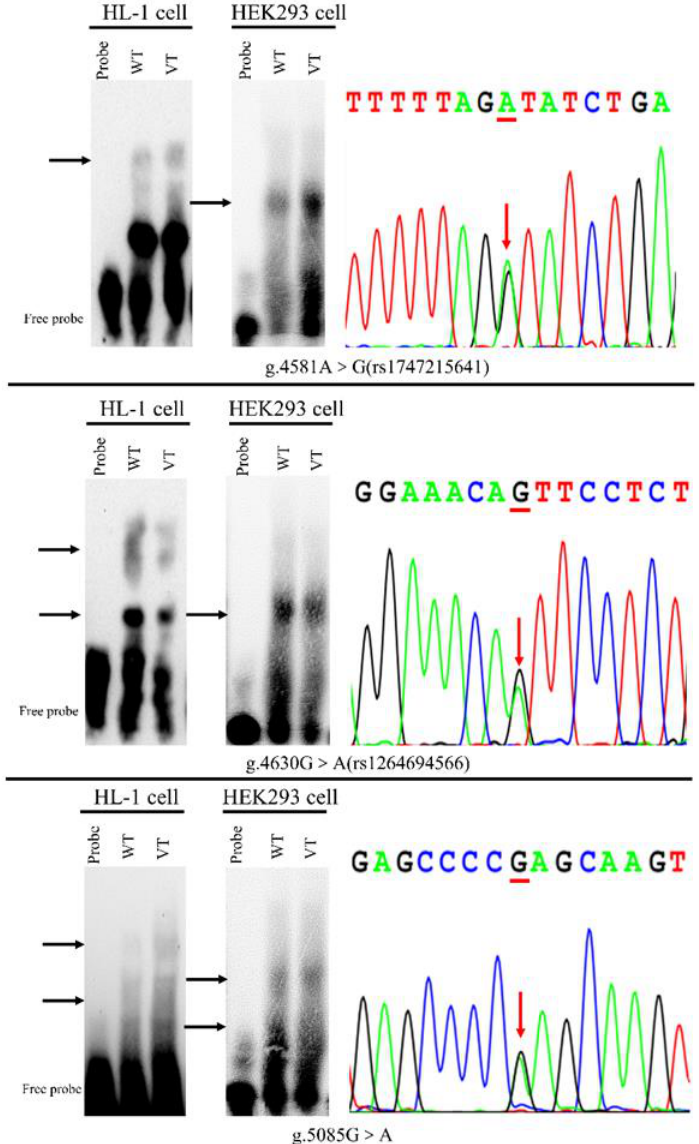
Figure 4. EMSA of biotin-labeled oligonucleotide-containing variants with nuclear extracts of HL-1 cells and HEK-293 cells. The amount of the labeled probe in VT and WT lane was the same. Free probe is at the bottom. The different binding for transcription factors between WT and VT is marked with arrows. Sequencing chromatograms of the three variants are represented at the right panel. WT, wild type, VT, variant type.